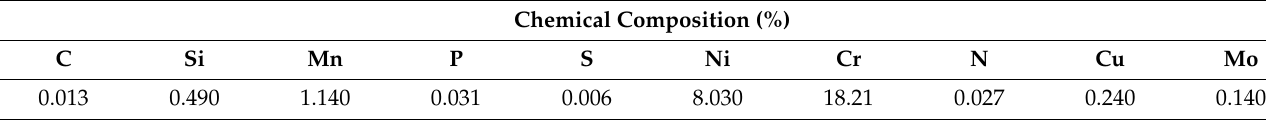
Table 1. Chemical composition of 304 L stainless steel.